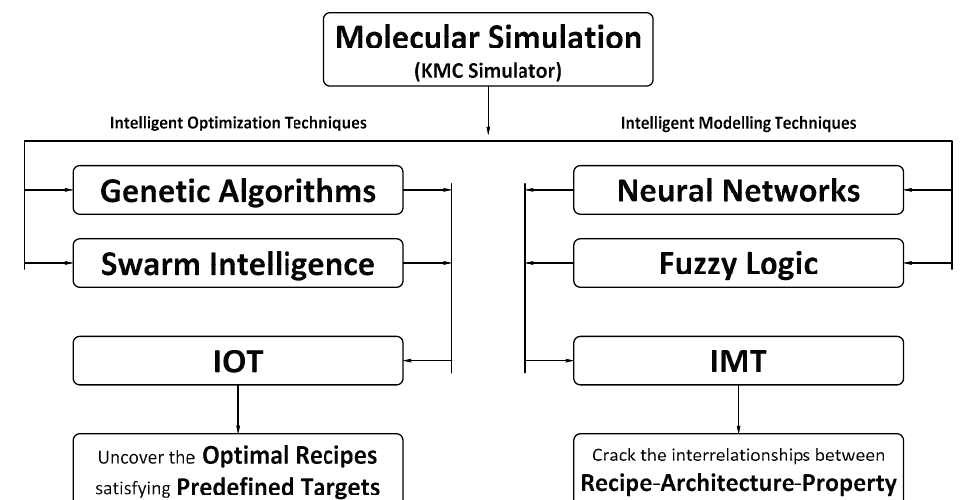
Figure 1. Illustrative description of the Intelligent Modeling Tool (IMT) and the Intelligent Optimization Tool (IOT) developed for tailoring the microstructure of olefin block copolymers (OBCs). KMC, Kinetic Monte Carlo.